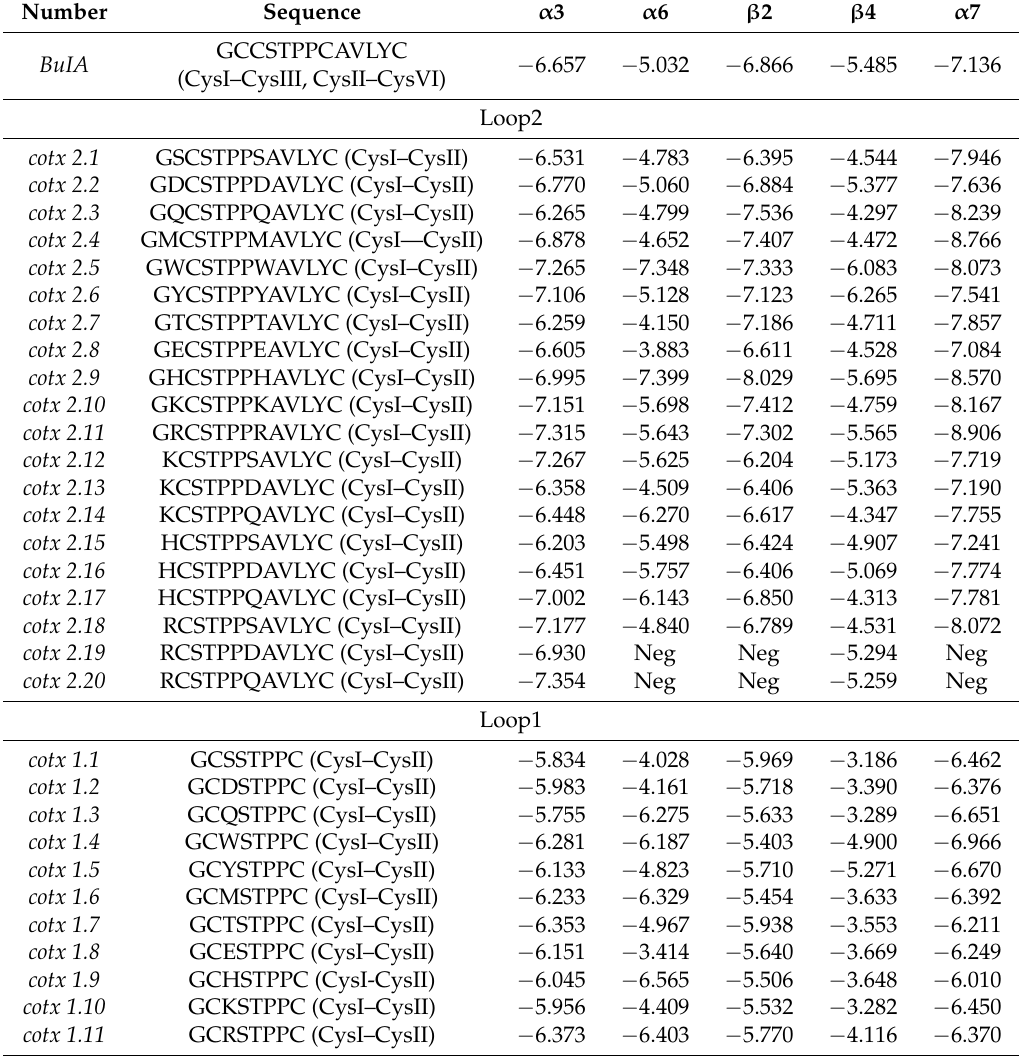
Table 1. The scores of Conus bullatus (BuIA) and